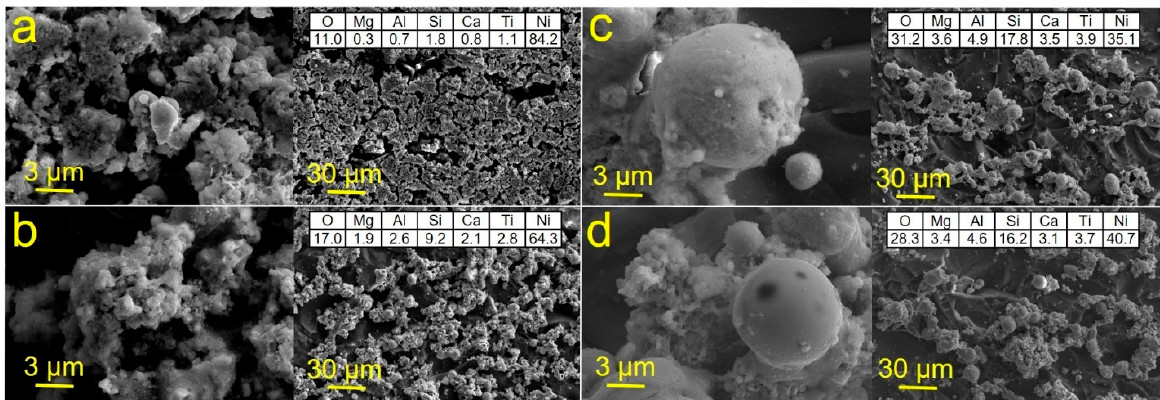
Figure 3. SEM images and results of EDX analysis (right top corner in each panel) of Ni patterns fabricated on glass- ceramics using SLS at the following laser fluences (J/cm 2 ) and scanning speeds (mm s − 1 ): ( a ) 0.0192 and 5; ( b ) 0.0154 and 5; ( c ) 0.0192 and 10; ( d ) 0.0154 and 10.